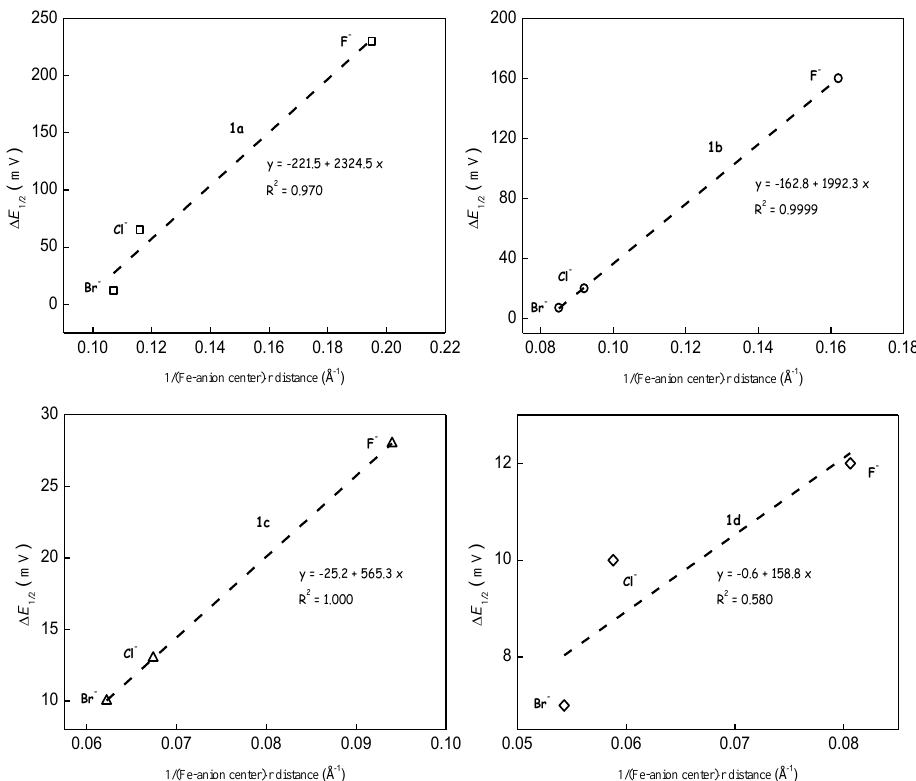
Figure 7. Anion-binding-induced potential shift as a function of the reciprocal of the Fe–anion distance and the radius of the anion when considering the intramolecular anion transfer process in ferrocene methylimidazolium receptor molecules 1a – 1d .